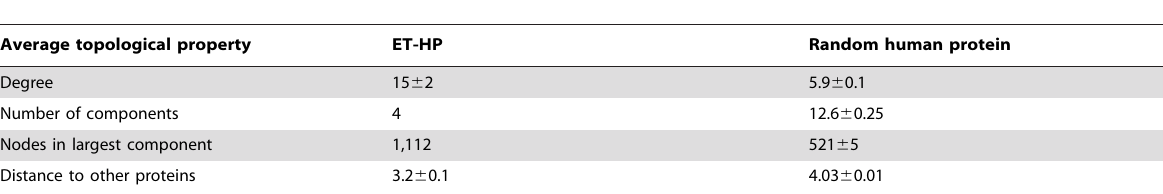
Table 2. Topological properties of human proteins for exercise